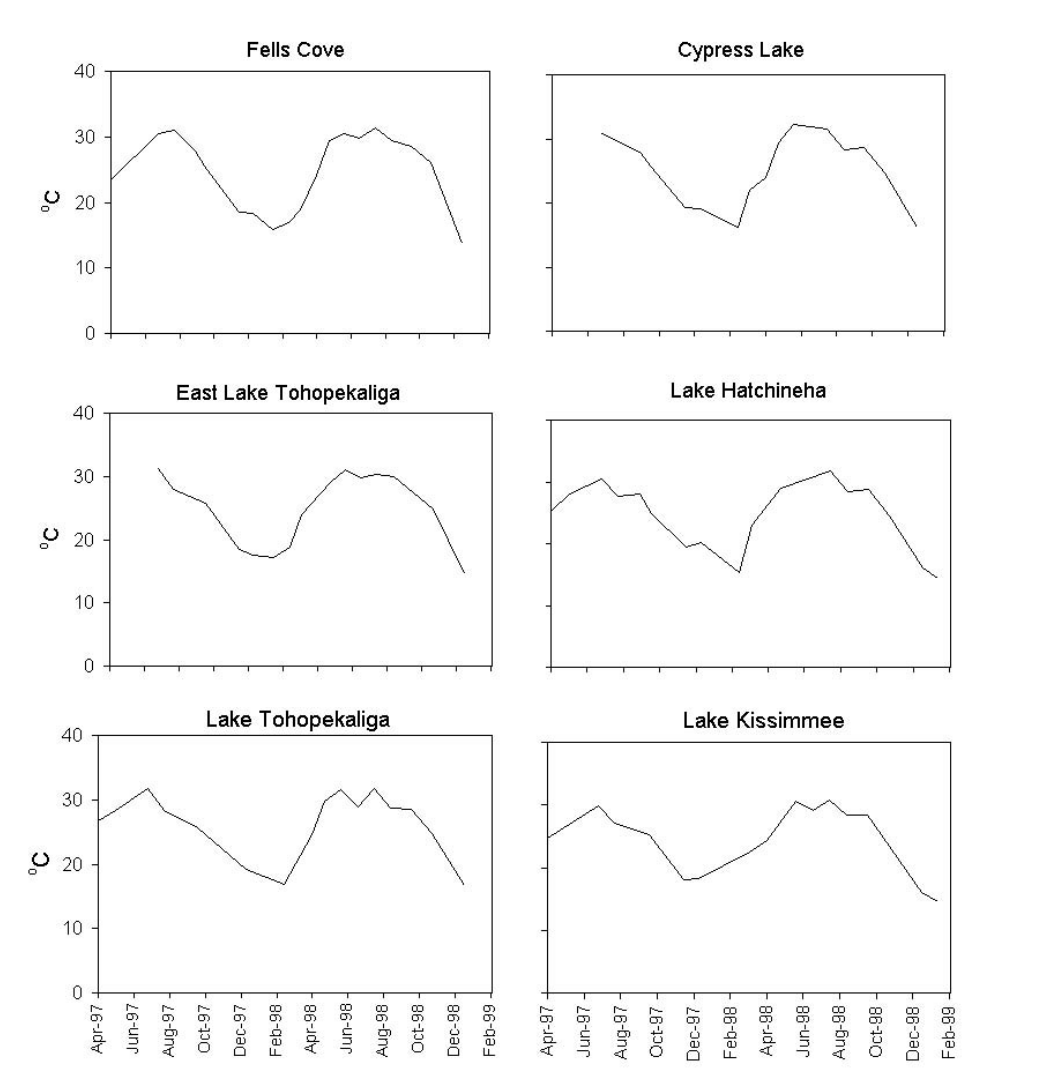
FIGURE 2. Near-surface water temperatures in the Kissimmee Chain-of-Lakes during 1997 and